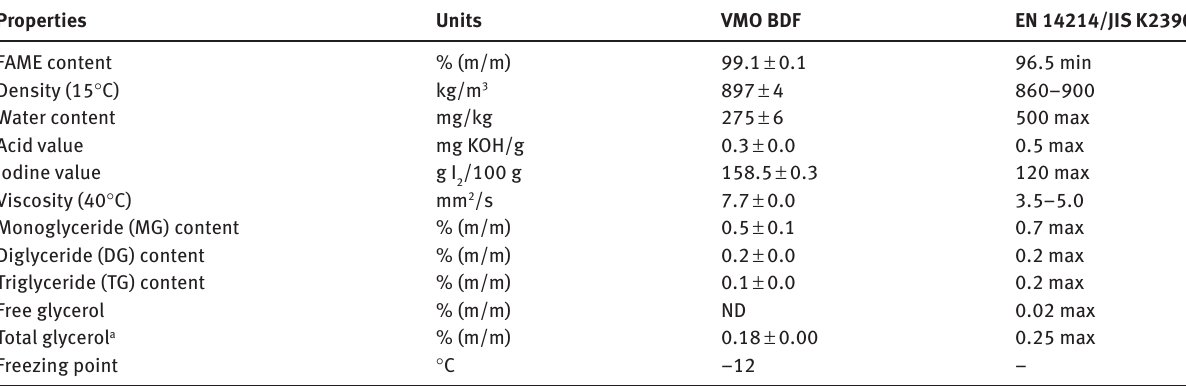
Table 2: Properties of VMO BDF.